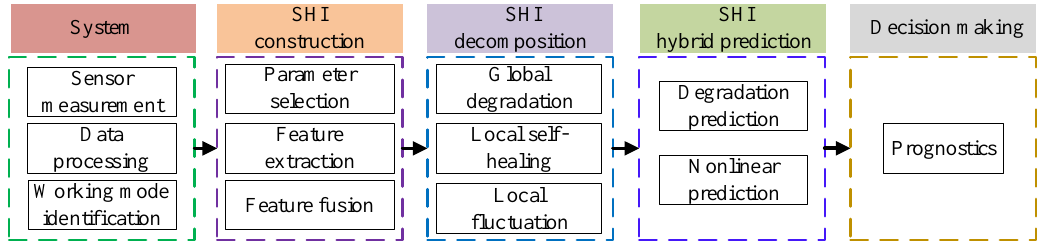
Figure 1. Schematic diagram of the proposed method for failure prognosis framework.